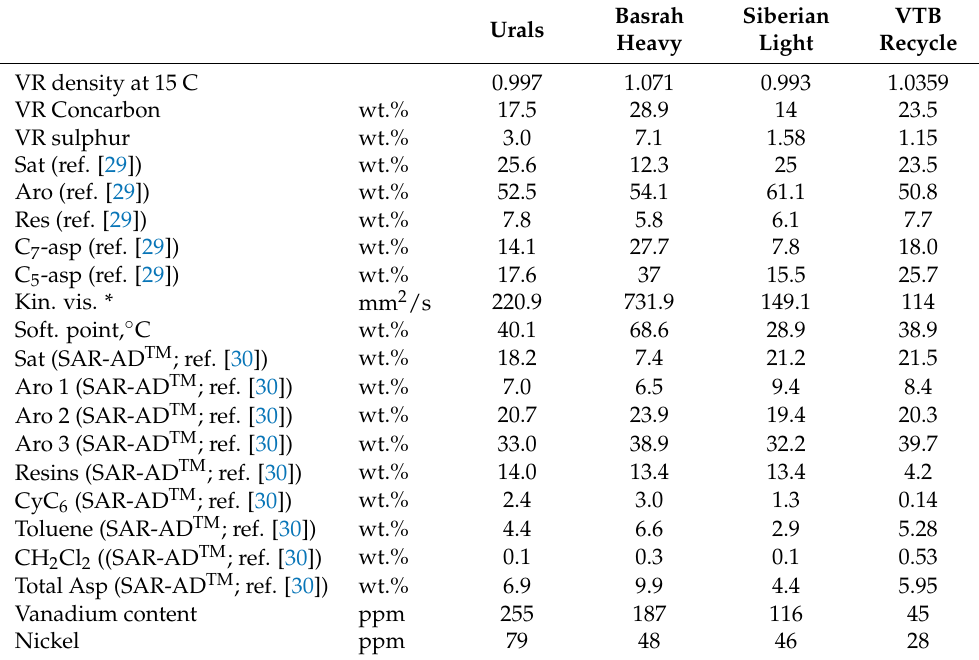
Vanadium content ppm